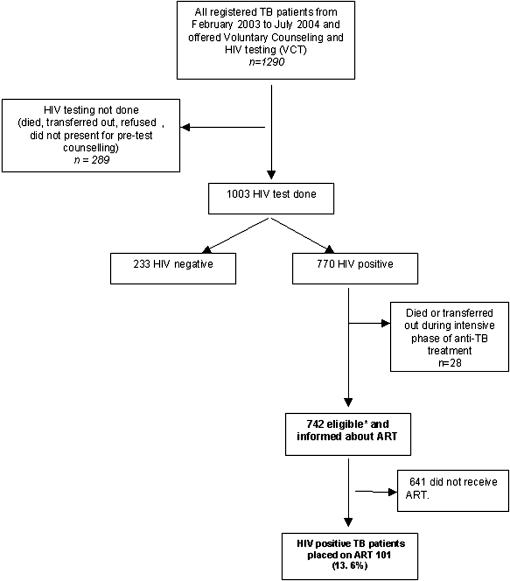
Uptake of antiretroviral treatment among tuberculosis patients.*Individuals who had completed their initial phase (2 months) of anti-TB treatment and were supposed to start ART during the period April 2003 to September 2004.